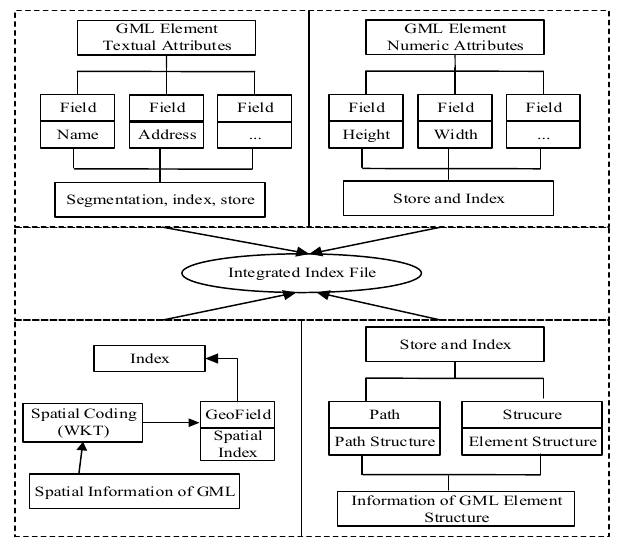
Figure 5. Index model for GML data.